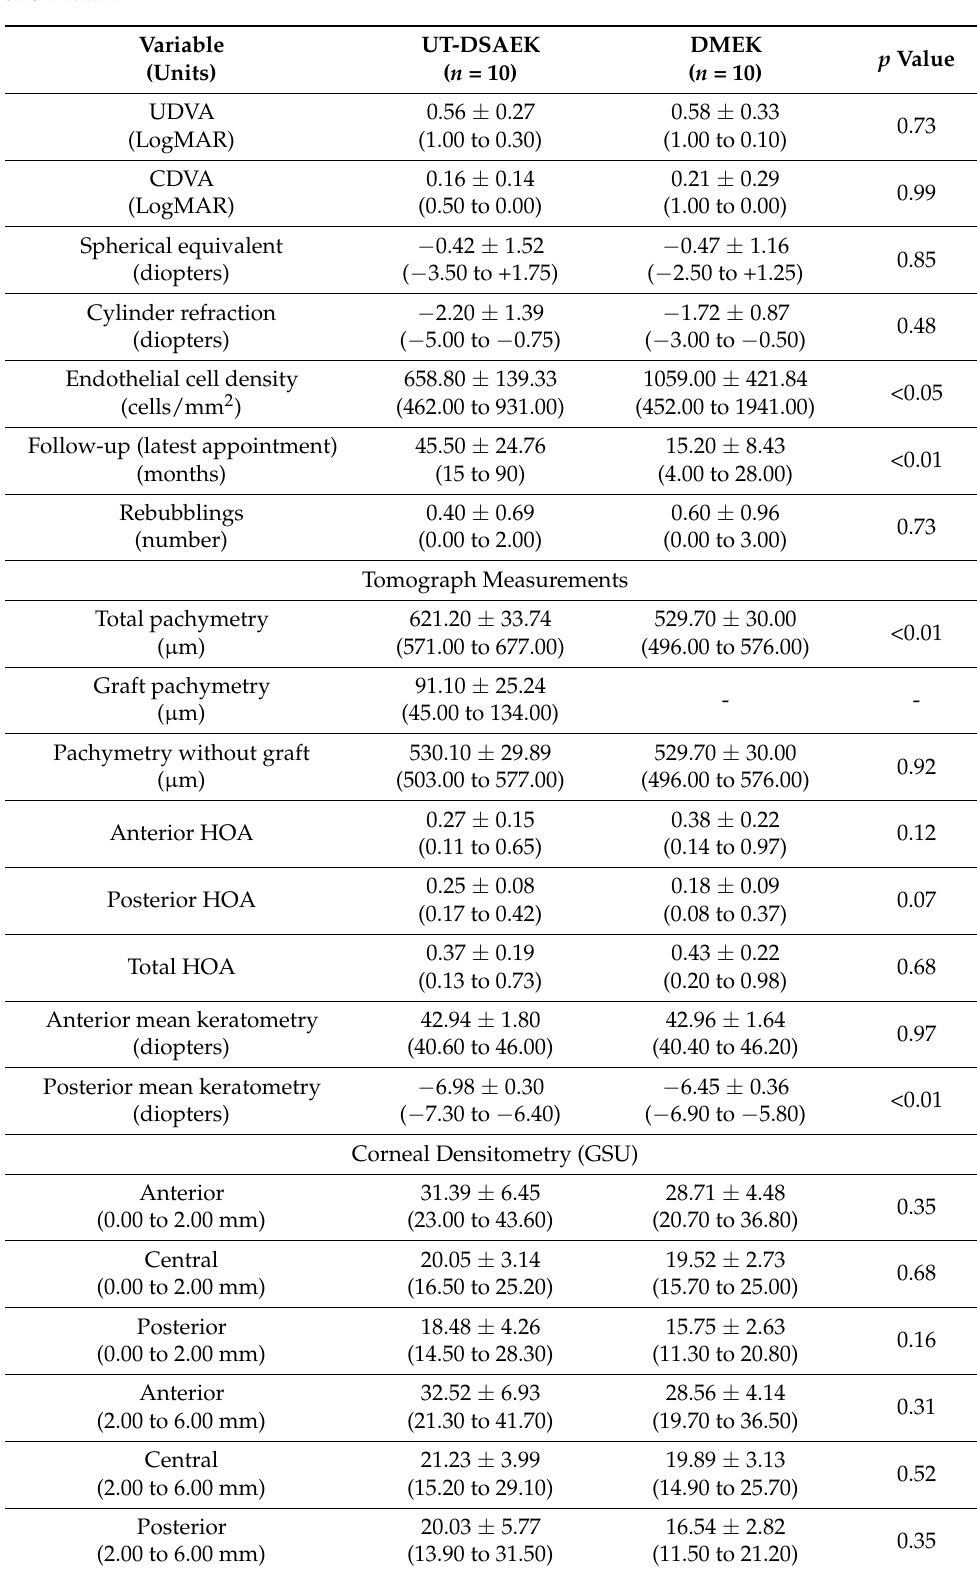
Table 1. Postoperative visual acuity, and refraction and tomograph differences between UT-DSAEK and